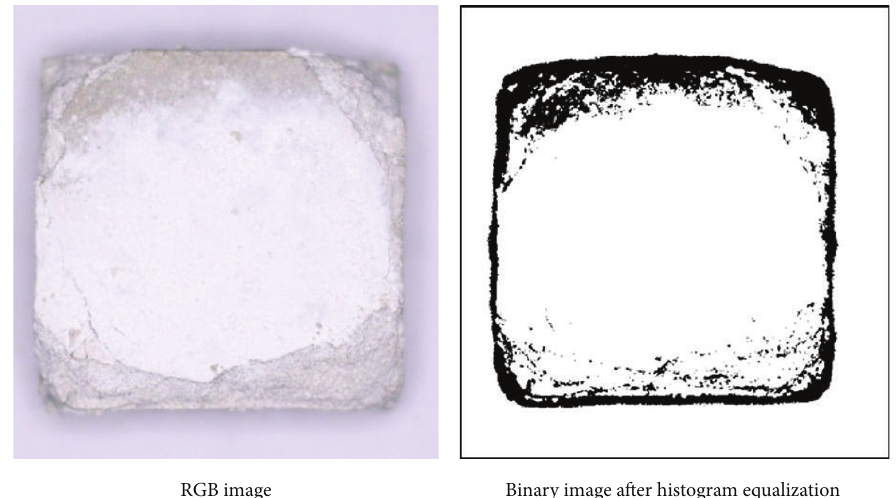
Figure 3: Failure in detecting boundary line without contrast